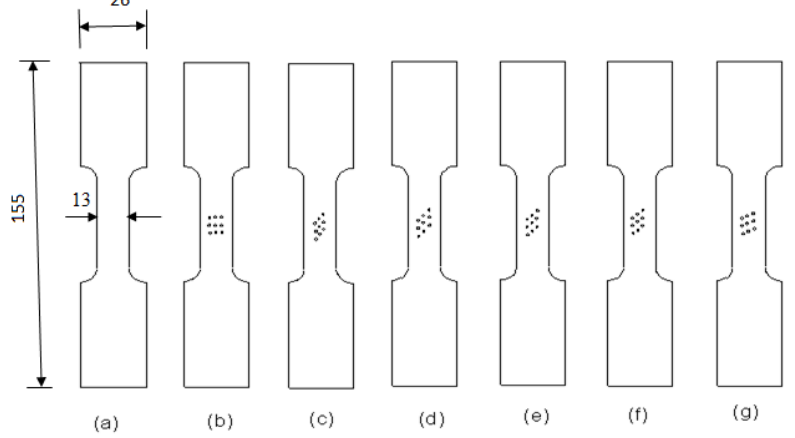
Figure 1: Rectangular specimen with arrays of holes at different orientations: (a) Specimen without hole, (b) hole array at 0 0 /90 0 , (c) at 30 0 , (d) at 40 0 , (e) at 45 0 , (f) at 50 0 and (g) at 60 0 .